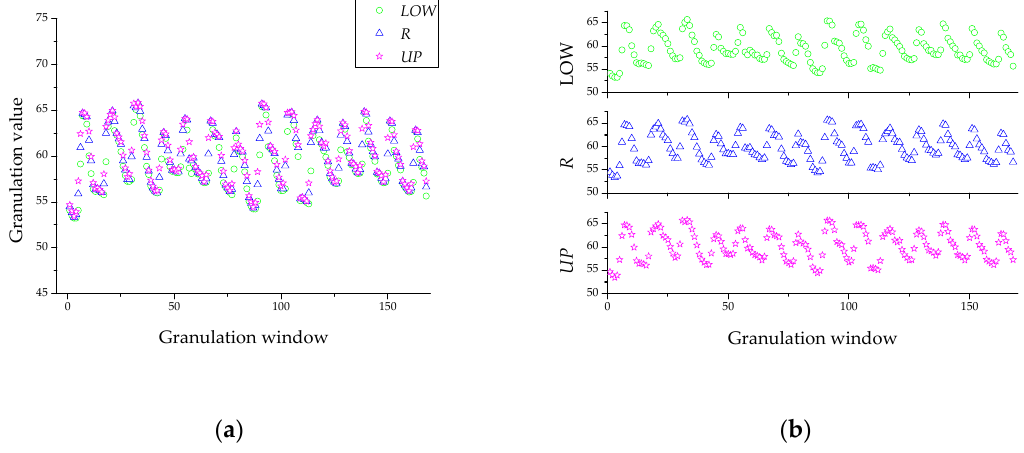
Figure 3. ( a ) General view of fuzzy information granulation (FIG); ( b ) separate views of FIG.